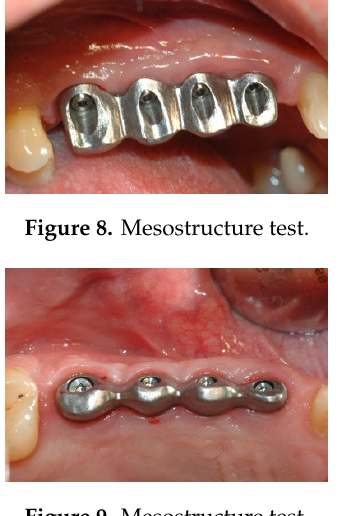
Figure 10. The built superstructure.